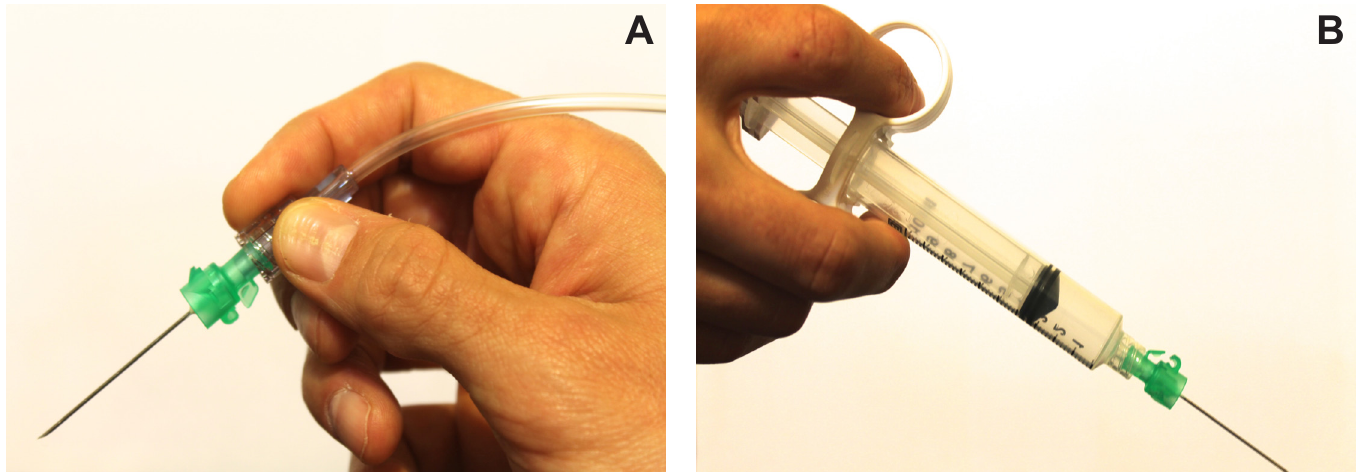
Figure 1. A, Hand-on-needle technique has the provider holding the needle hub in a pencil-like fashion while resting their hand on the body surface. B, Hand-on-syringe technique has the operator hold the syringe rather than the needle, enabling them to aspirate and inject local anesthetic without the use of an